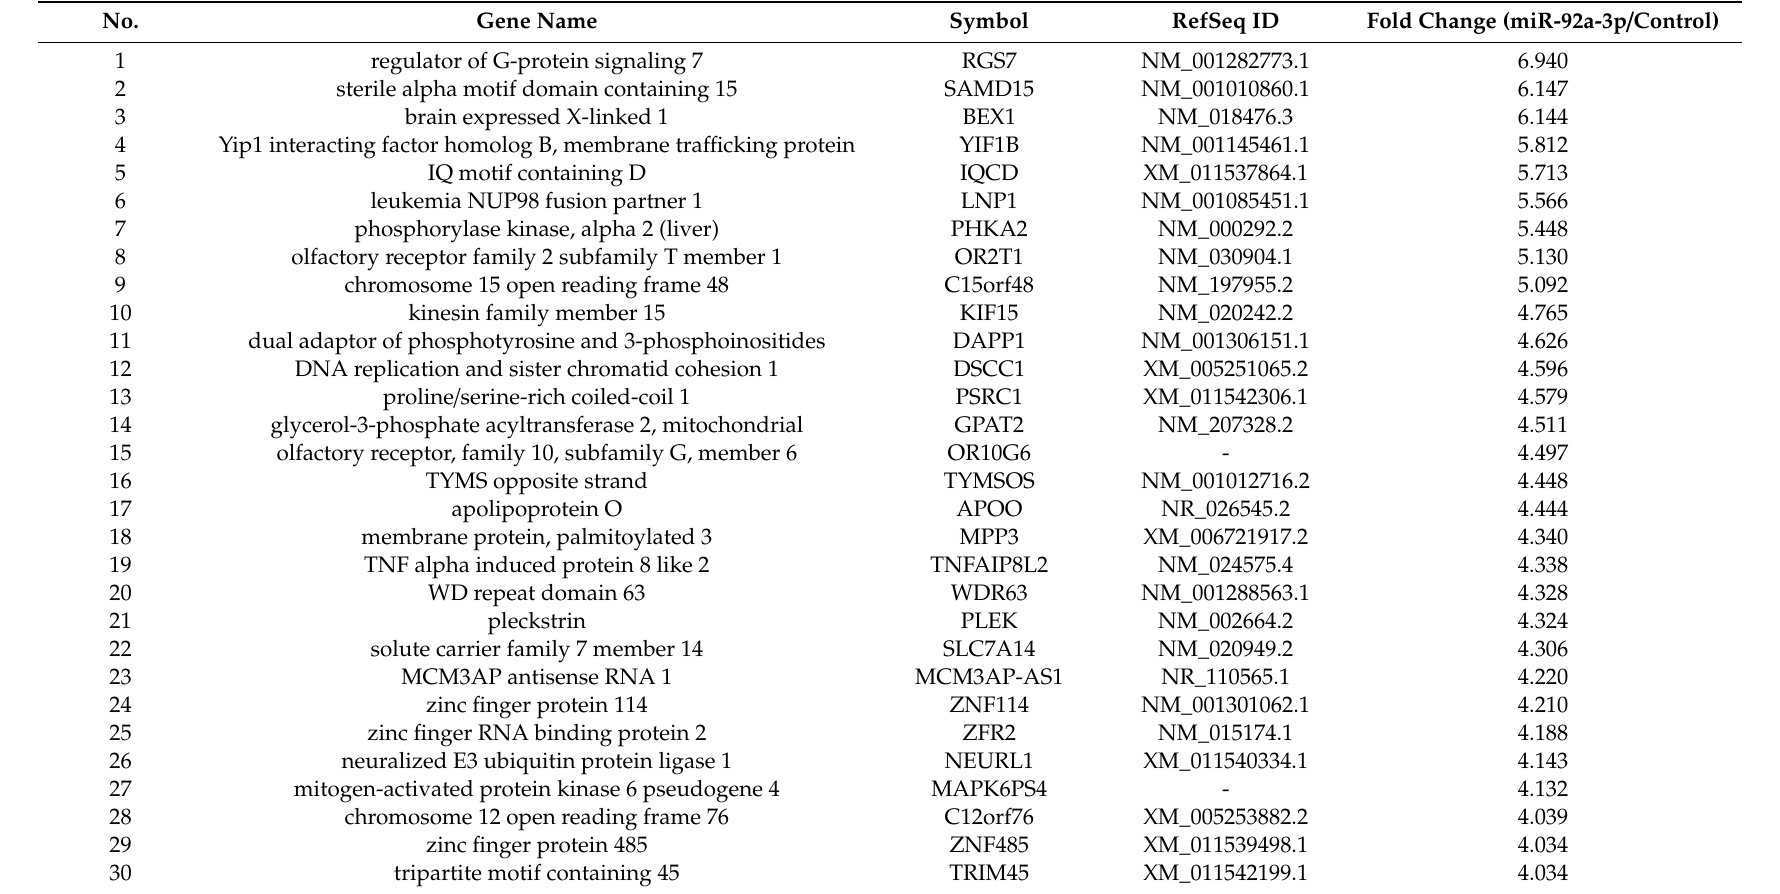
Table 1. More than a four-fold upregulation of DEGs in HUVECs transfected with